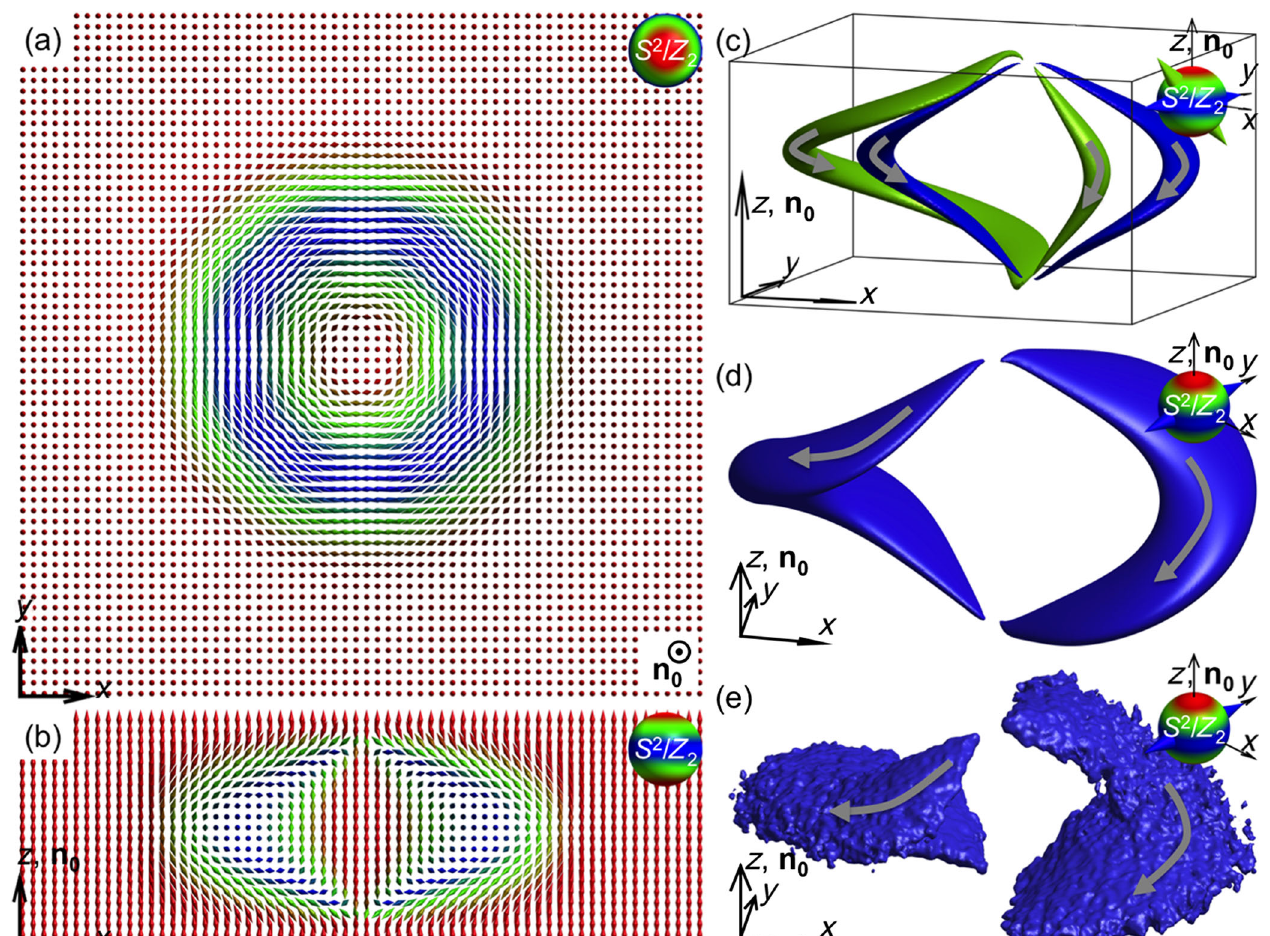
FIG. 3. Elementary toron structure in a confined chiral nematic LC. (a), (b) Computer-simulated (a) in-plane and (b) vertical cross sections of n ð r Þ of the toron depicted using double cones and the color scheme that establishes correspondence between director orientations and the points on S 2 =Z 2 (top right insets). (c) Computer-simulated preimages of the toron for two sets of the diametrically opposite points on S 2 =Z 2 marked by double cones in the top right inset. (d), (e) Comparison of representative (d) computer-simulated and (e) experimental preimages of the toron for two diametrically opposite points on the “ equator ” of S 2 =Z 2 (top right insets). The experimental preimages in (e) are reconstructed based on 3PEF-PM images of structures in a 5CB-based partially polymerizable nematic LC mixture with chiral additive CB-15, d ¼ 10 μ m, and d=p ∼ 1 ; before imaging, the unpolymerized 5CB is washed out and replaced by immersion oil. Gray arrows indicate the consistently determined circulations of the preimages. Computer simulations are performed for 5CB elastic constants while also assuming K 24 ¼ 0